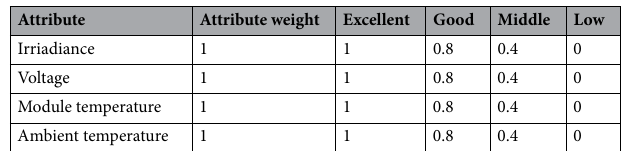
Table 1. The attribute reference